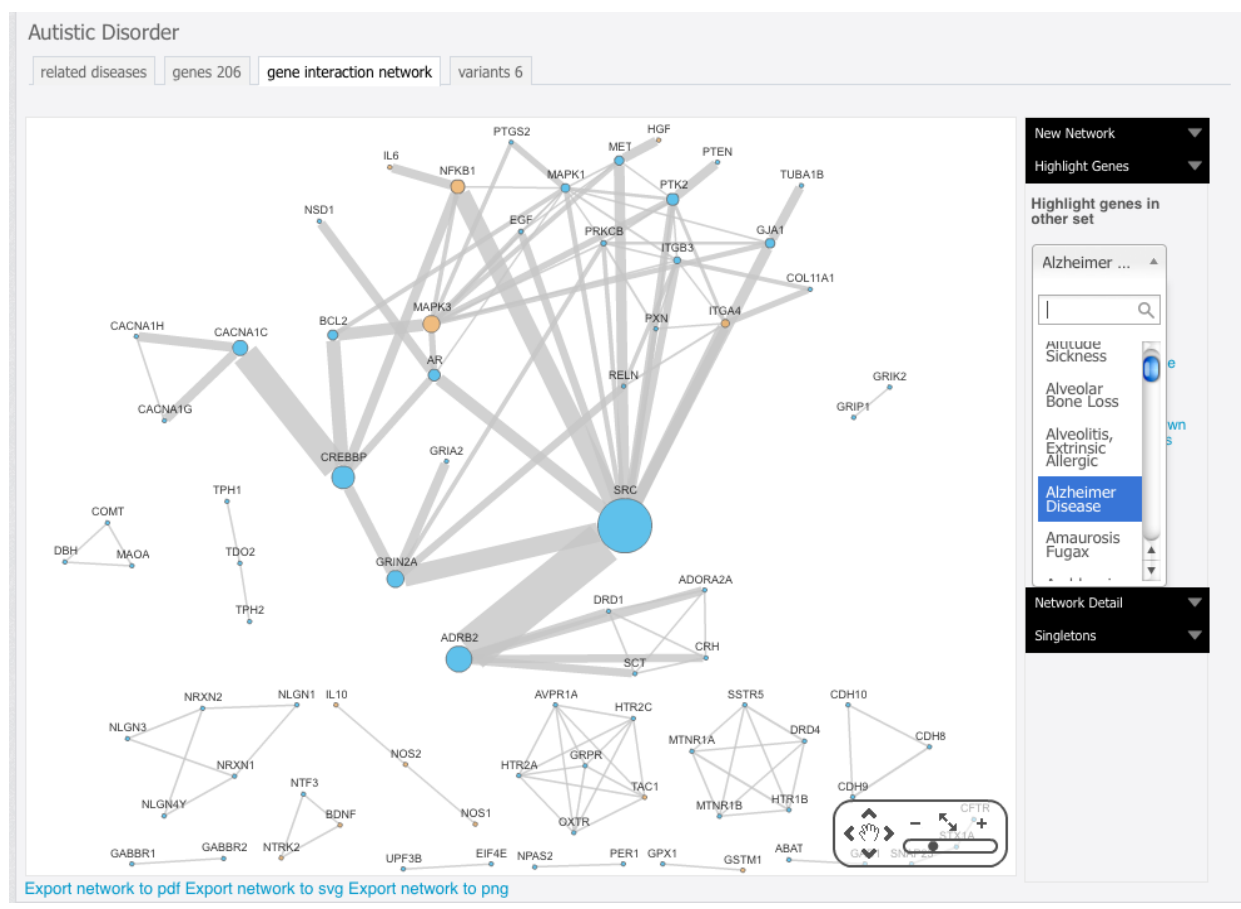
Figure 6. Cross-disease gene interaction comparison of Alzheimer’s disease with the autism network as provided by Autworks [35]. Orange nodes represent overlapped genes between these